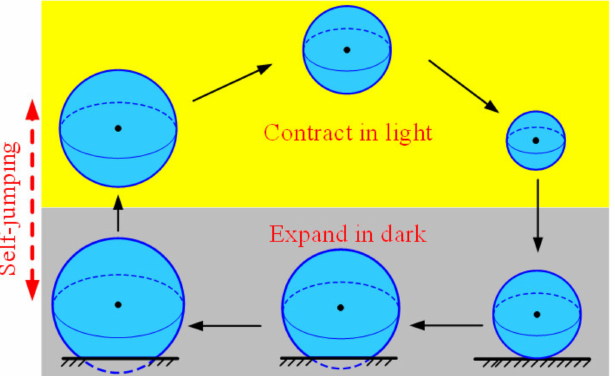
Figure 4. The process of the self-jumping LCE balloon in one cycle. The LCE balloon contracts in the illumination zone, while it expands in the dark zone. Due to the expansion of the balloon during the contact between the LCE balloon with rigid surface, the contact force does positive net work to maintain the self-jumping.